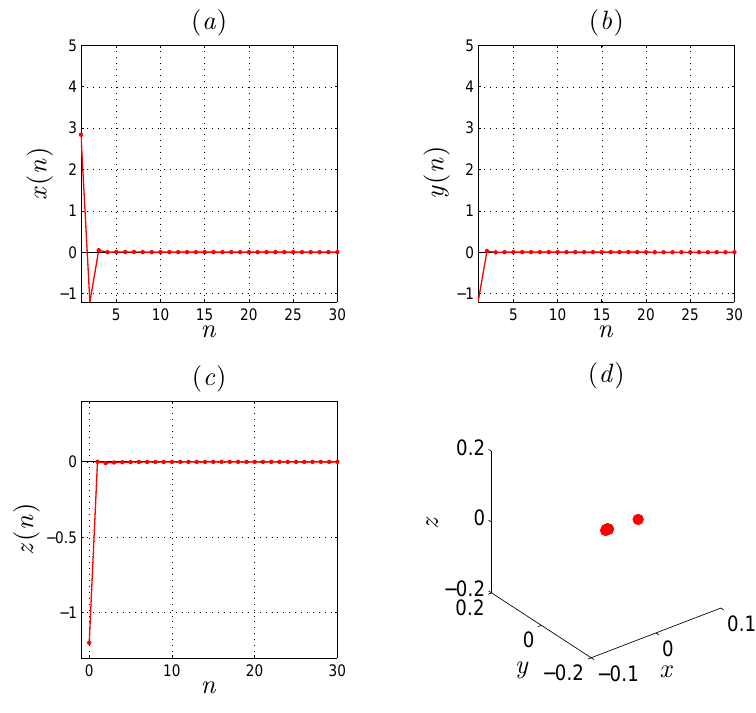
Figure 7. Stabilization of the states and attractor of the controlled system (15), when γ = 0.998 ( a ) Evolution of the state x ( n ) , ( b ) Evolution of stabilized state y ( n ) , ( c ) Evolution of the state z ( n ) , ( d ) Phase portrait of the controlled system